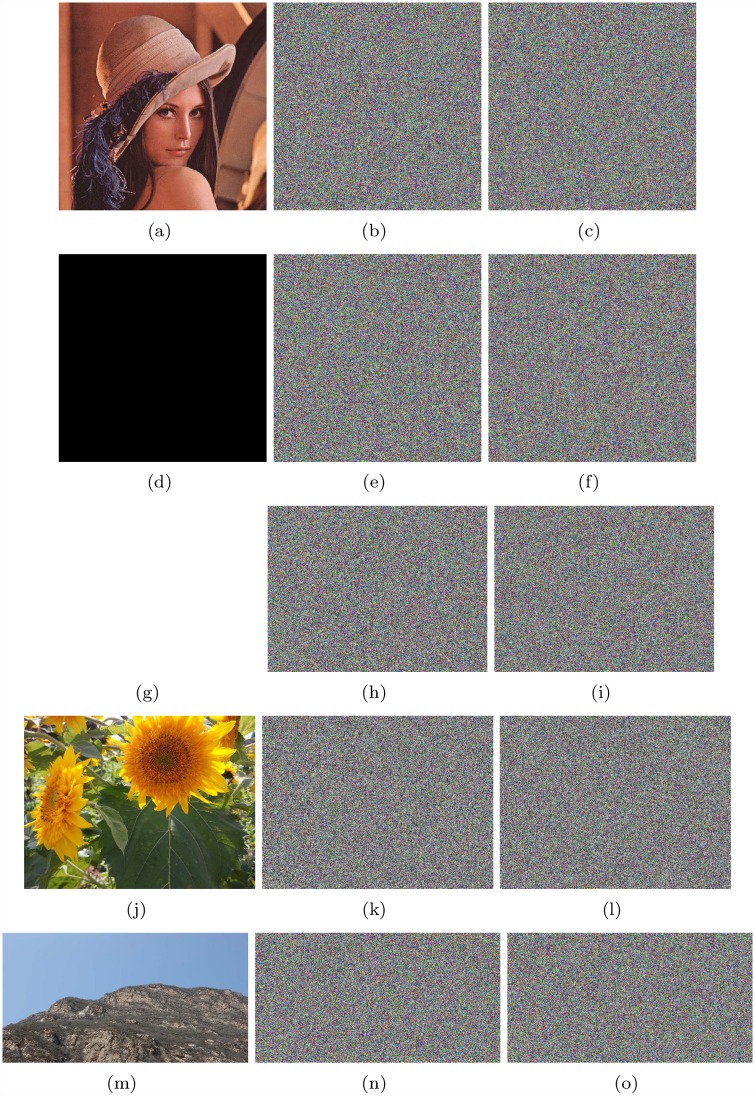
NPCR and UACI of Lena, all-zero image, white, flower and mountain.(a) Plain image Lena; (b) Encrypted image of Lena; (c) Encrypted image of Lena with a pixel changed; (d) all-zero Image; (e)Encrypted image of all-zero Image; (f)Encrypted image of all-zero with a pixel changed; (g) Plain image white; (h) Encrypted image of white; (i) Encrypted image of white with a pixel changed; (j) Plain image flower; (k) Encrypted image of flower; (l) Encrypted image of flower with a pixel changed; (m) Plain image mountain; (n) Encrypted image of mountain; (o) Encrypted image of mountain with a pixel changed.